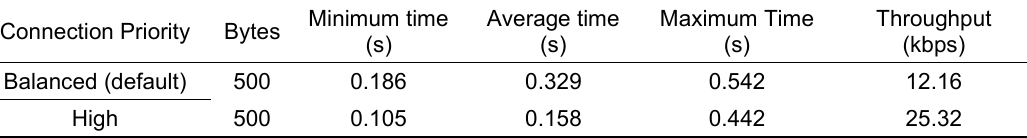
Table 3. Data transfer delay (in seconds) and throughput from the PSoC device to the Android smartphone using BLE and different connection